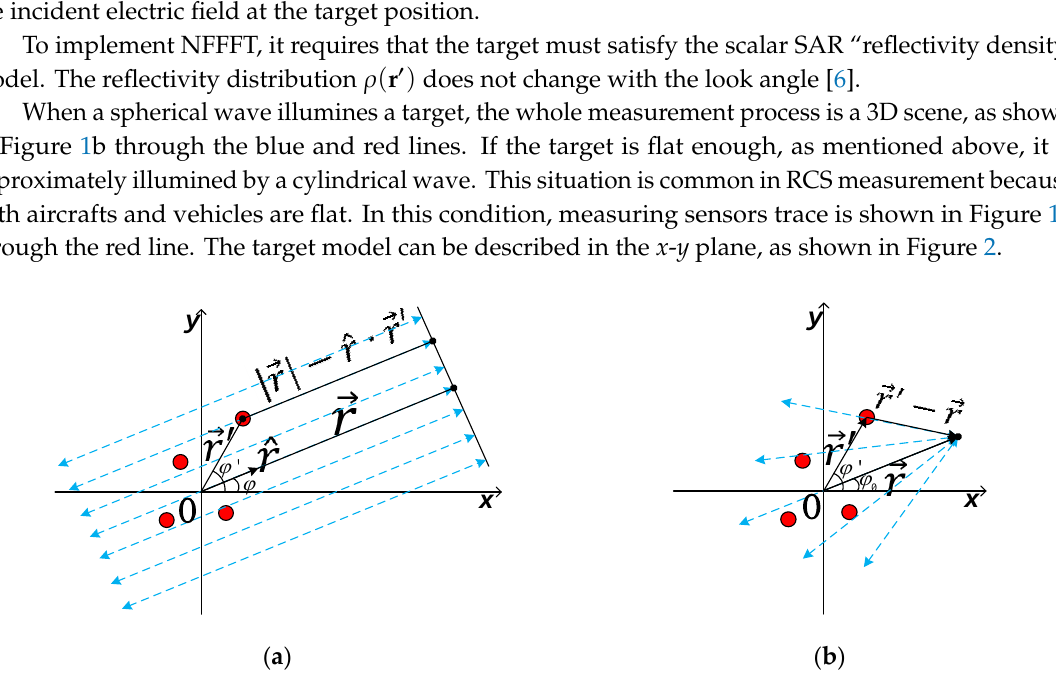
Figure 2. Two-dimensional far-field and near-field condition: ( a ) Far-field condition; ( b ) Near-field condition.